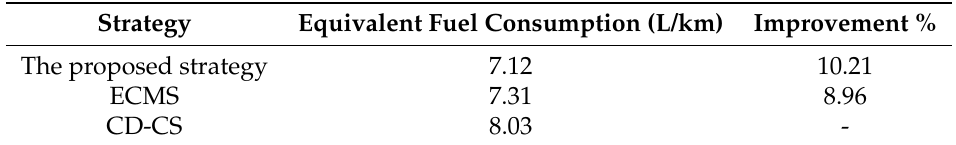
Table 6. Comparison of equivalent energy consumption when the initial SOC is